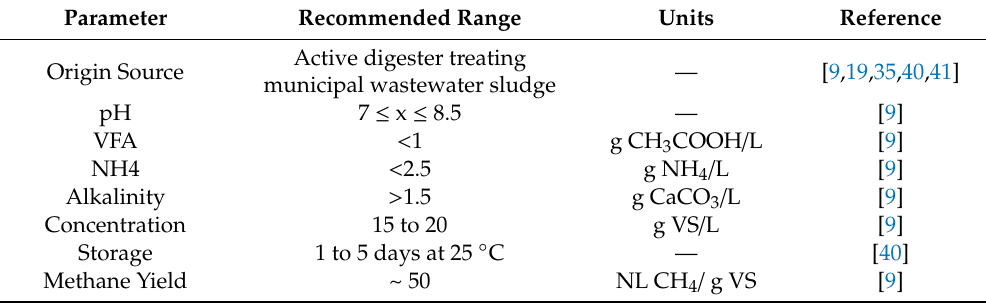
Table 1. Recommended inoculum conditions for BMP tests.